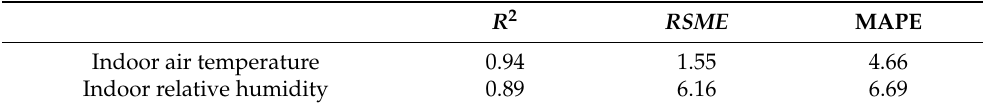
Table 5. Statistical analysis by air temperature and humidity for model